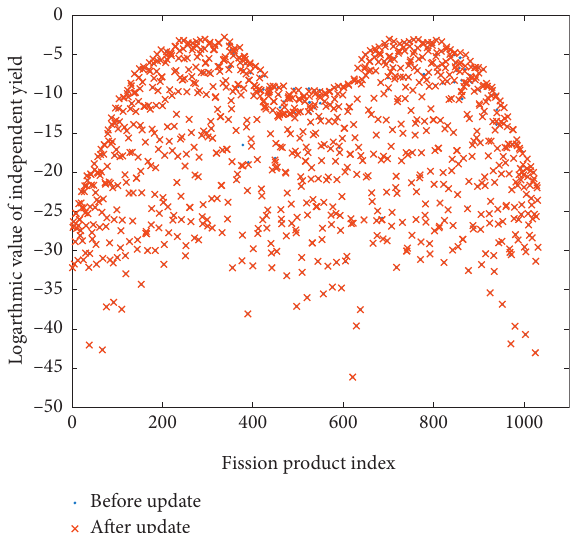
Figure 7: IFYs standard deviation (STD) distribution before and after sequential Bayesian updating. Natural logarithm is presented on the y -scale. The fission product index refers to each fission product identified by its charge number Z , mass number A , and isomeric state I ( ZZAAAI ) . These indices are grouped by the mass number and arranged in a descending